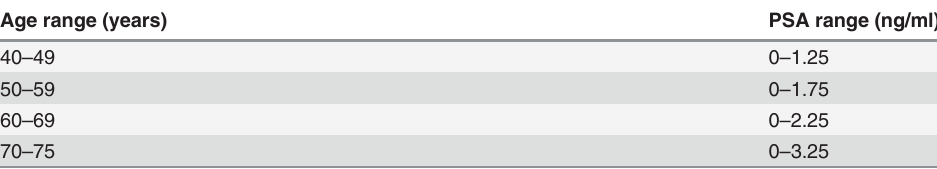
Table 2. Age adjusted biopsy